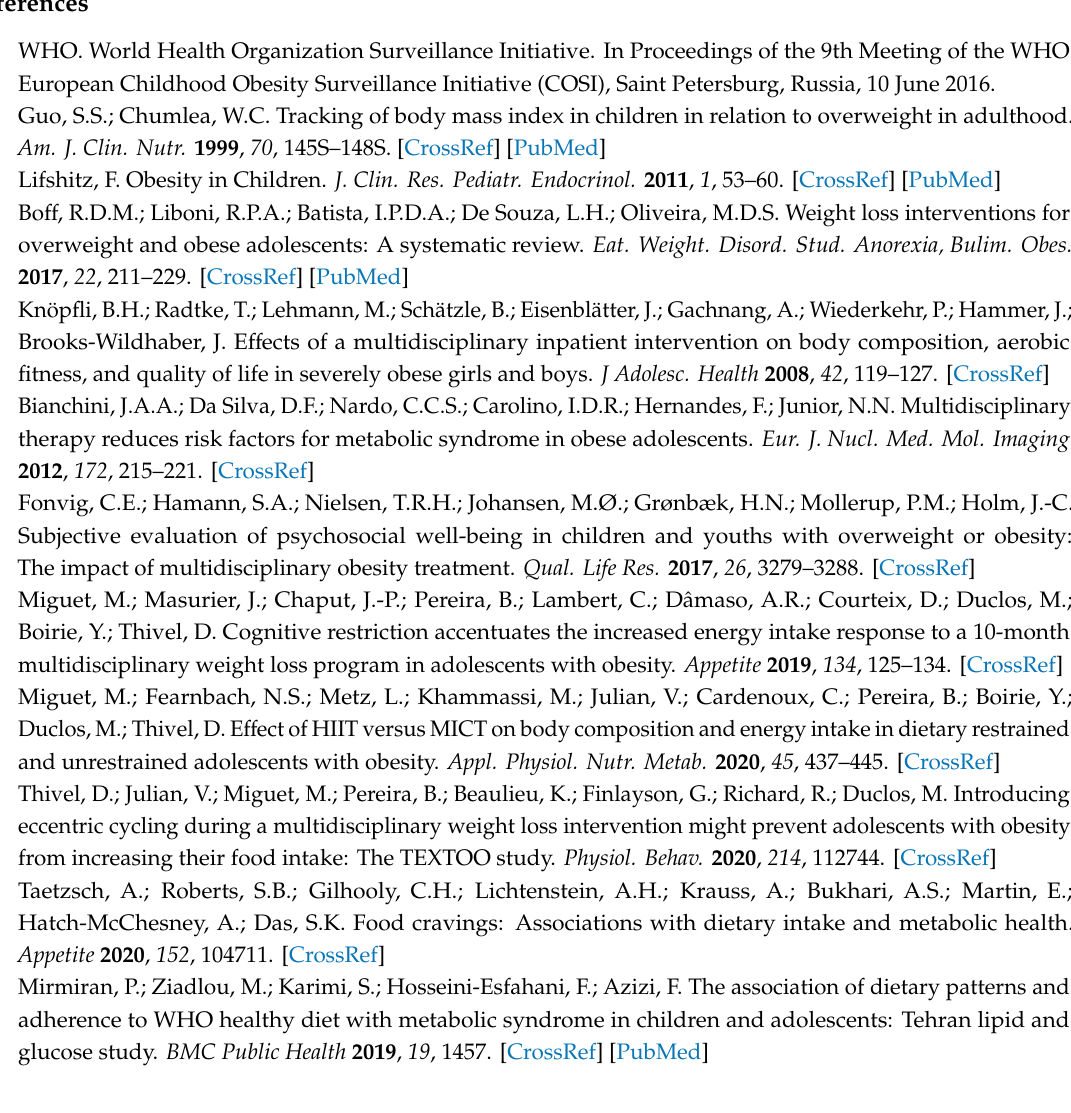
Table S1: Appetite sensation between T0 and T1 for the whole sample and MS and non-MS subsamples, Table S2: Appetite sensation between Persistent vs. non-persistent adolescents at T1 and between non-MS T0 and non-Persistent at